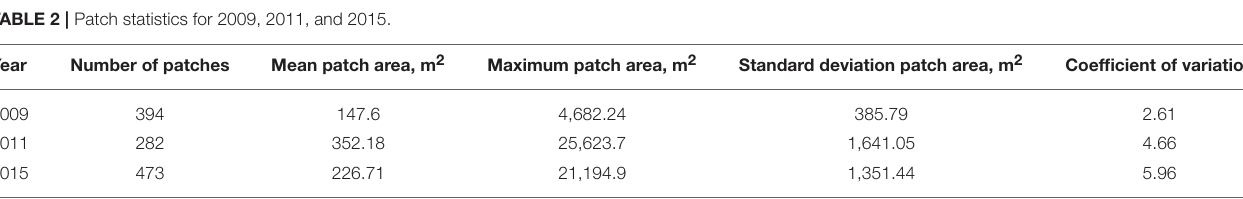
TABLE 2 | Patch statistics for 2009, 2011, and